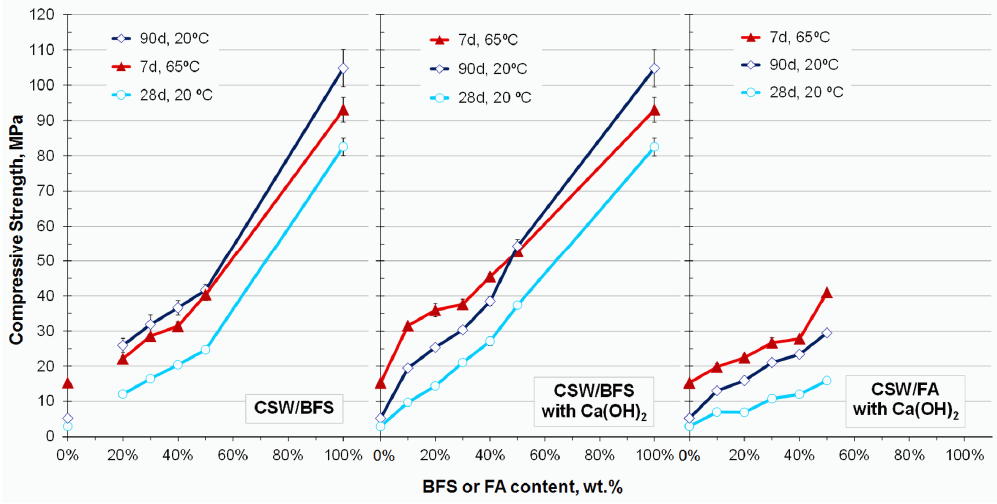
Figure 4. Evolution of compressive strength with the BFS and FA contents in the alkali-activated CSW mortars cured at 65 °C for 7 days and at 20 °C for 28 and 90 days.